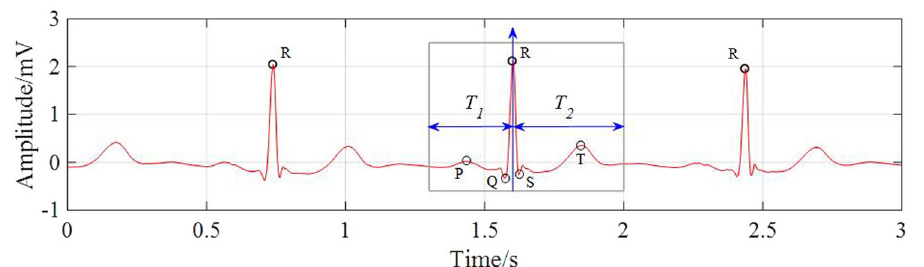
Figure 2. Beat segmentation of a typical ECG